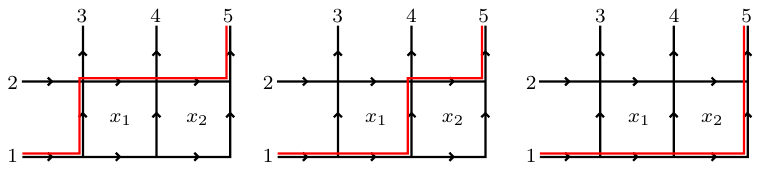
Figure 14 . For Web 2 ; 5 there are three complete collections of non-intersecting paths in Path (2 ; 5), each consisting of one path.